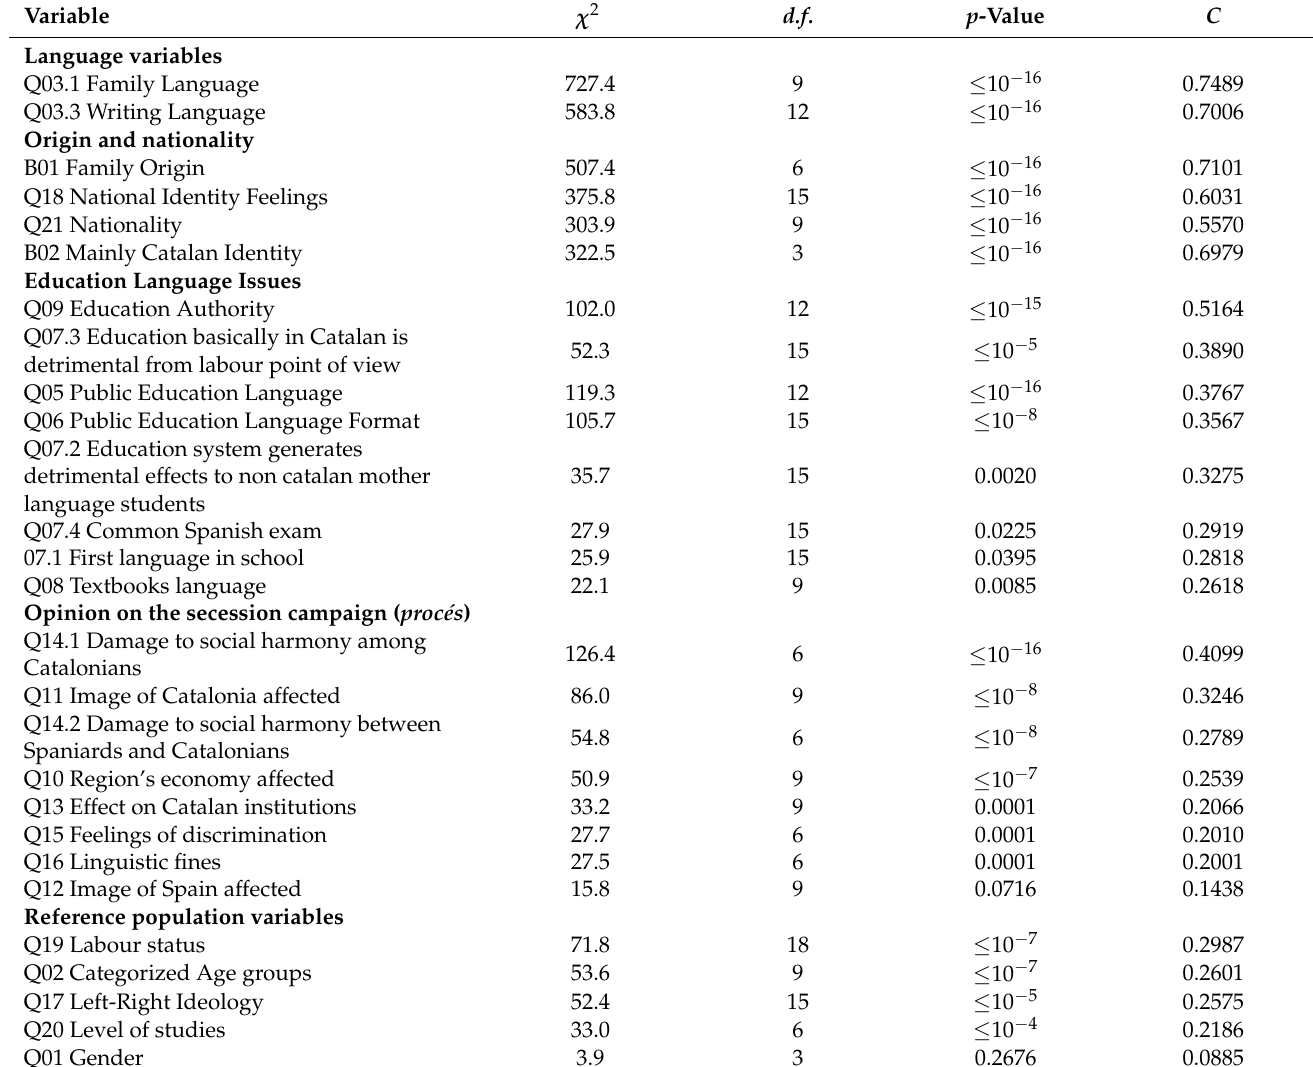
Table 3. Association coefficients of the “ mother language ” segments (“Catalan”, “Spanish”, “both languages”, “other languages”) with each of the remaining variables. (These denote different opinions, preferences, and traits derived from a GAD-3 survey in December 2020 with a sample size of n = 1002 (or n = 402 for a group of variables) Catalonian residents. The variables are grouped in consideration of their nature, and each group is presented in descending order, from the top down, of the magnitude of association, as measured by the contingency coefficient, C . Only the variables of “ gender ” and “ image of Spain affected ” presented an insignificant stochastic dependence on “ mother language”, while all of the remaining variables exhibited clear stochastic dependence on this